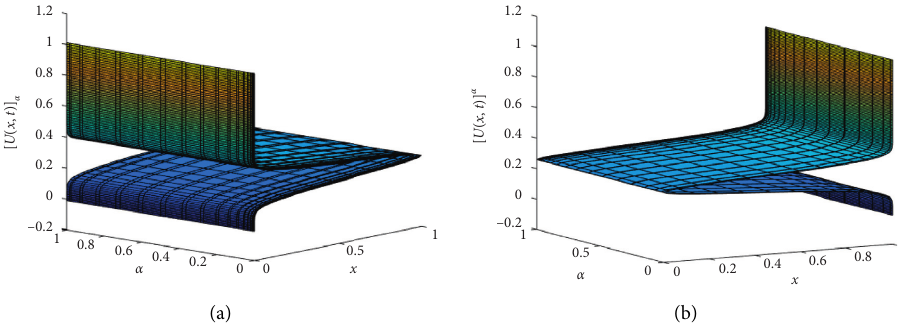
Figure 2: The surface of intuitionistic fuzzy